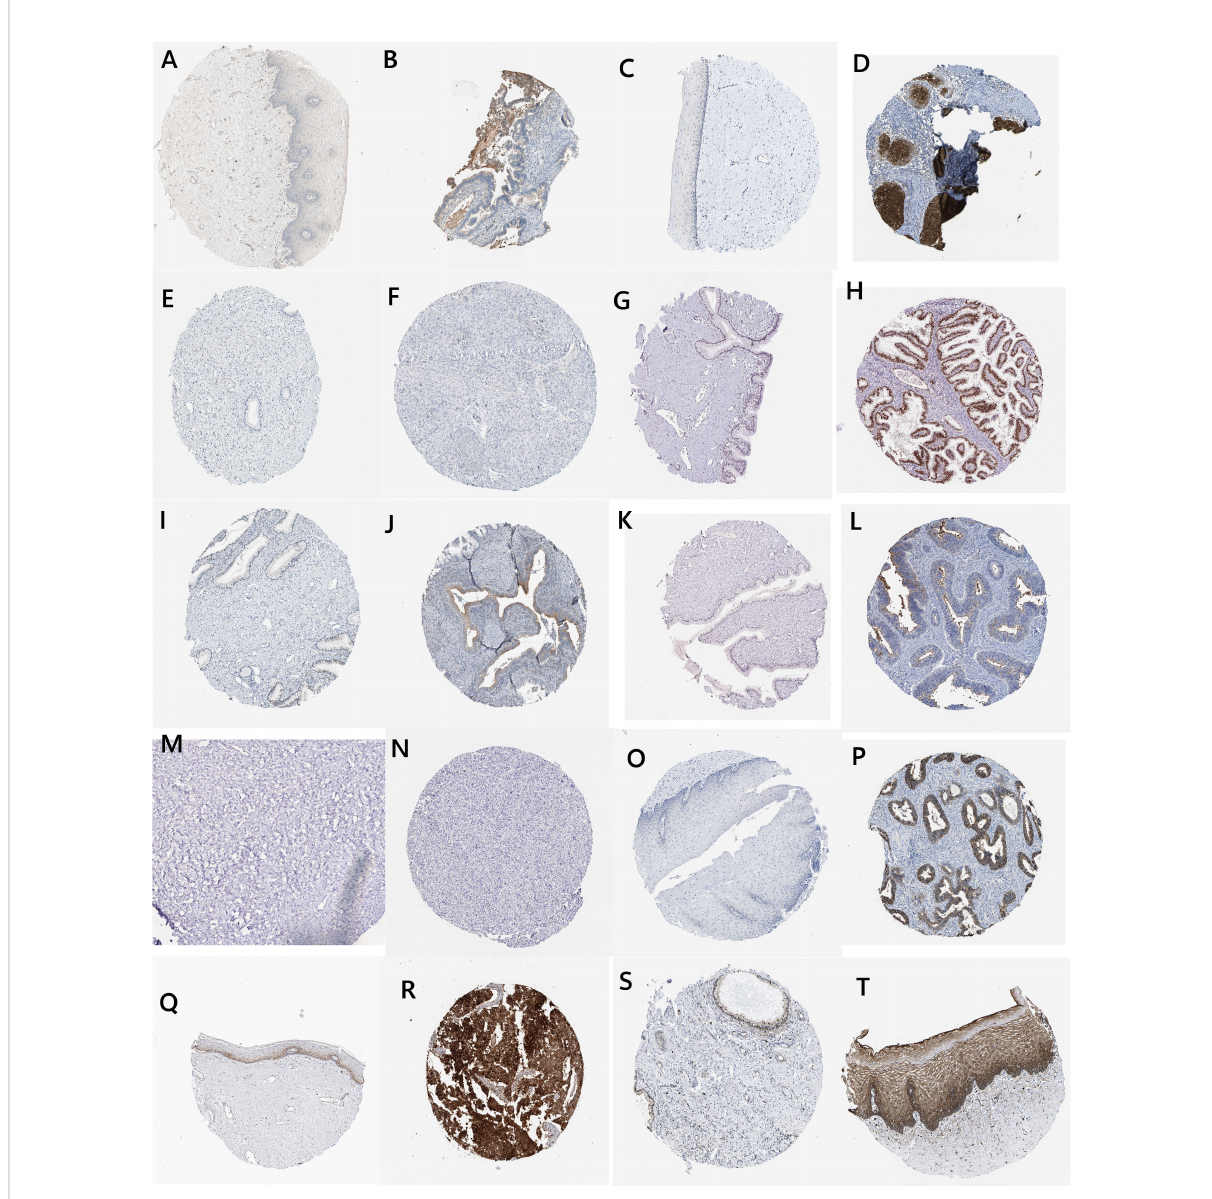
FIGURE 7 Histological and immunohistochemical images (IFNG: A , normal; B , tumor ALOX15; C , normal; D , tumor ALOX12B; E , normal; F , tumor HELLS; G , normal; H , tumor DUOX1; I , normal, J , tumor MIOX; K , normal; L , tumor CDO1; M , normal; N , tumor CA9; O , normal; P , tumor TFRC; Q , normal; R , tumor SCD; and S , normal; T ,